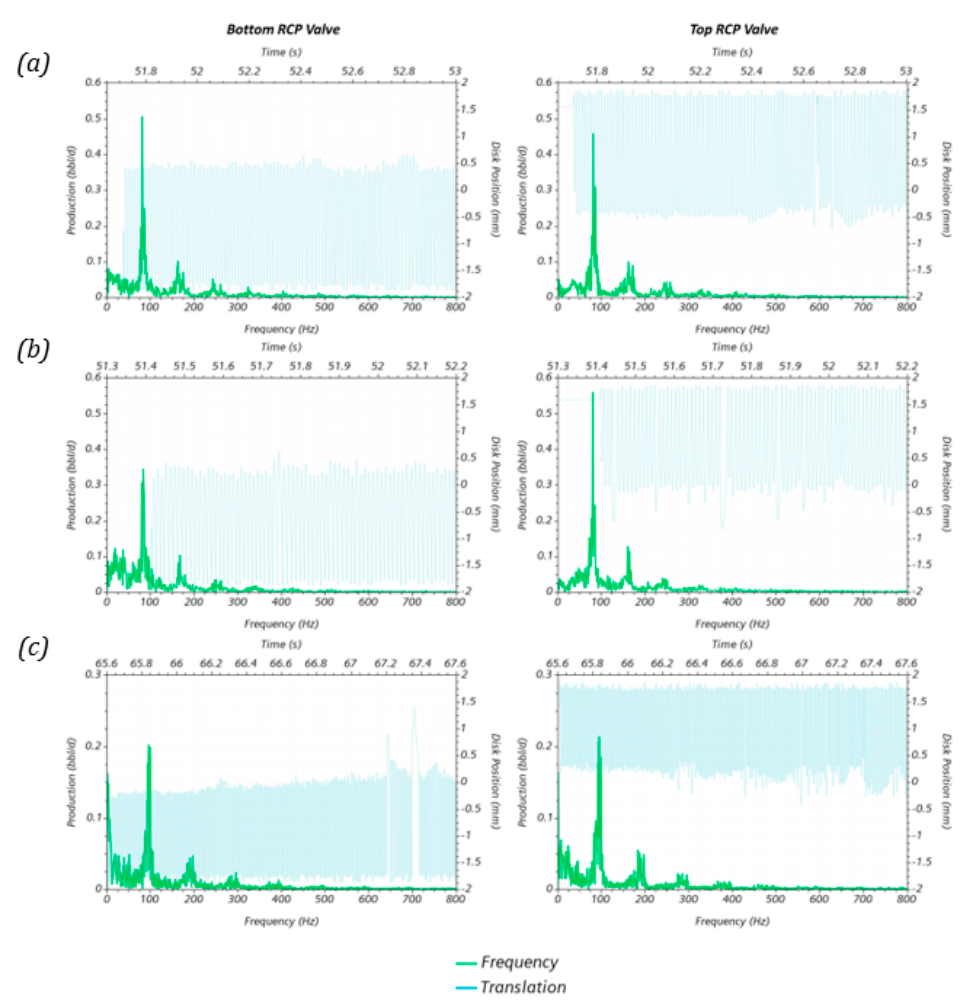
Figure 14. Results of the oscillation and frequency profile for the two RCP valves for the oil viscosity sensitivity analysis, ( a ) µ oil = 0.2, ( b ) µ oil = 0.4, and ( c ) µ oil = 0.8 Pa ·